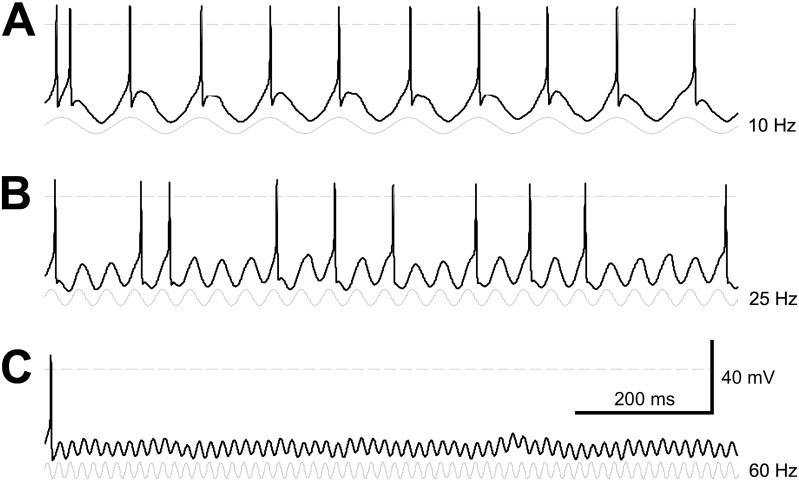
Patch-clamp recording of responses to sinusoidal stimulus currents.Representative membrane potential recordings from an A2o-type retinal ganglion cell, during intracellular injection of sinusoidal stimulation currents (70 pA) at (A) 10 Hz, (B) 25 Hz, and (C) 60 Hz. The frequency and phase of the injected currents are indicated by the sinusoids (gray) shown below each membrane potential recording (black). The dashed line indicates 0 mV.